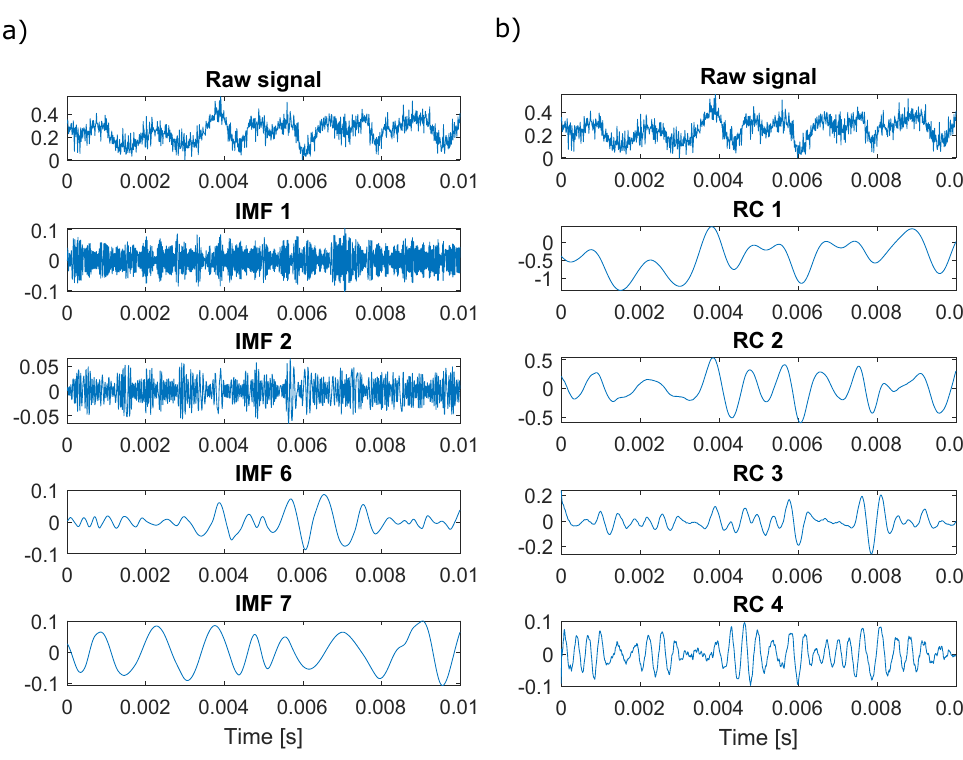
Figure 3. Raw signal and selected components from its decomposition with ( a ) EMD and ( b ) SSA at TOA 25% for p s − imp 1 outlet